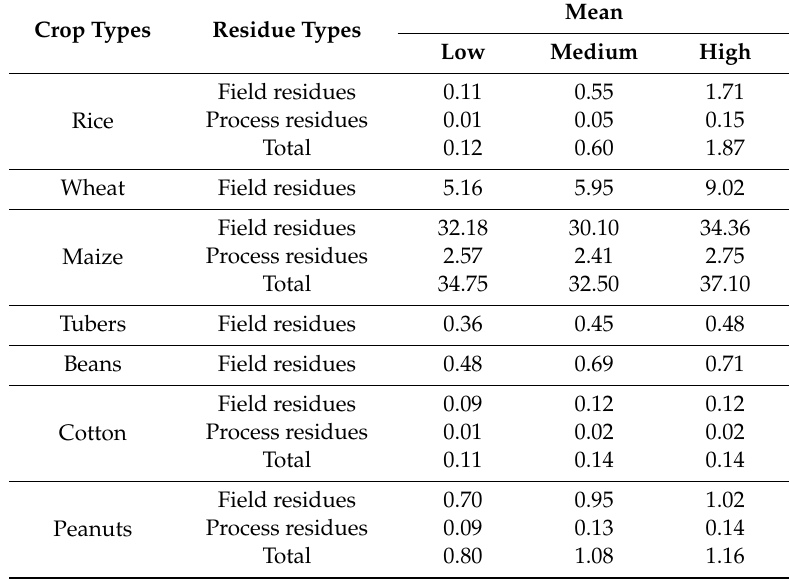
Table 5. The collectable potential availability (10 4 t) of crop residues.